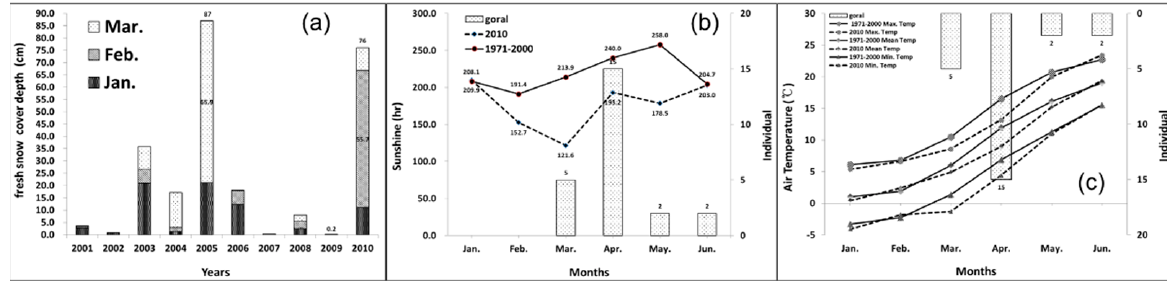
Figure 1. Climatic conditions in 2010 compared to those in other years. ( a ) Monthly average fresh snow cover depth (cm) for three months (January: dark bar, February: intermediate dark bar, and March: light bar) from 2001 to 2010, ( b ) monthly average sunshine (hr) and ( c ) air temperature for six months (from January to June) of 2010 (dotted line), compared to that between 1971 and 2000 (line) and the monthly number of dead gorals.